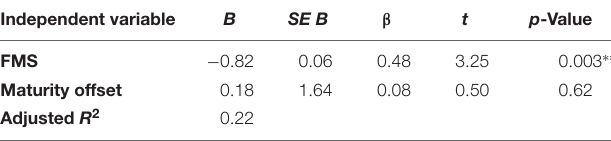
TABLE 5 | Multiple regression of FMS and maturity offset on physical